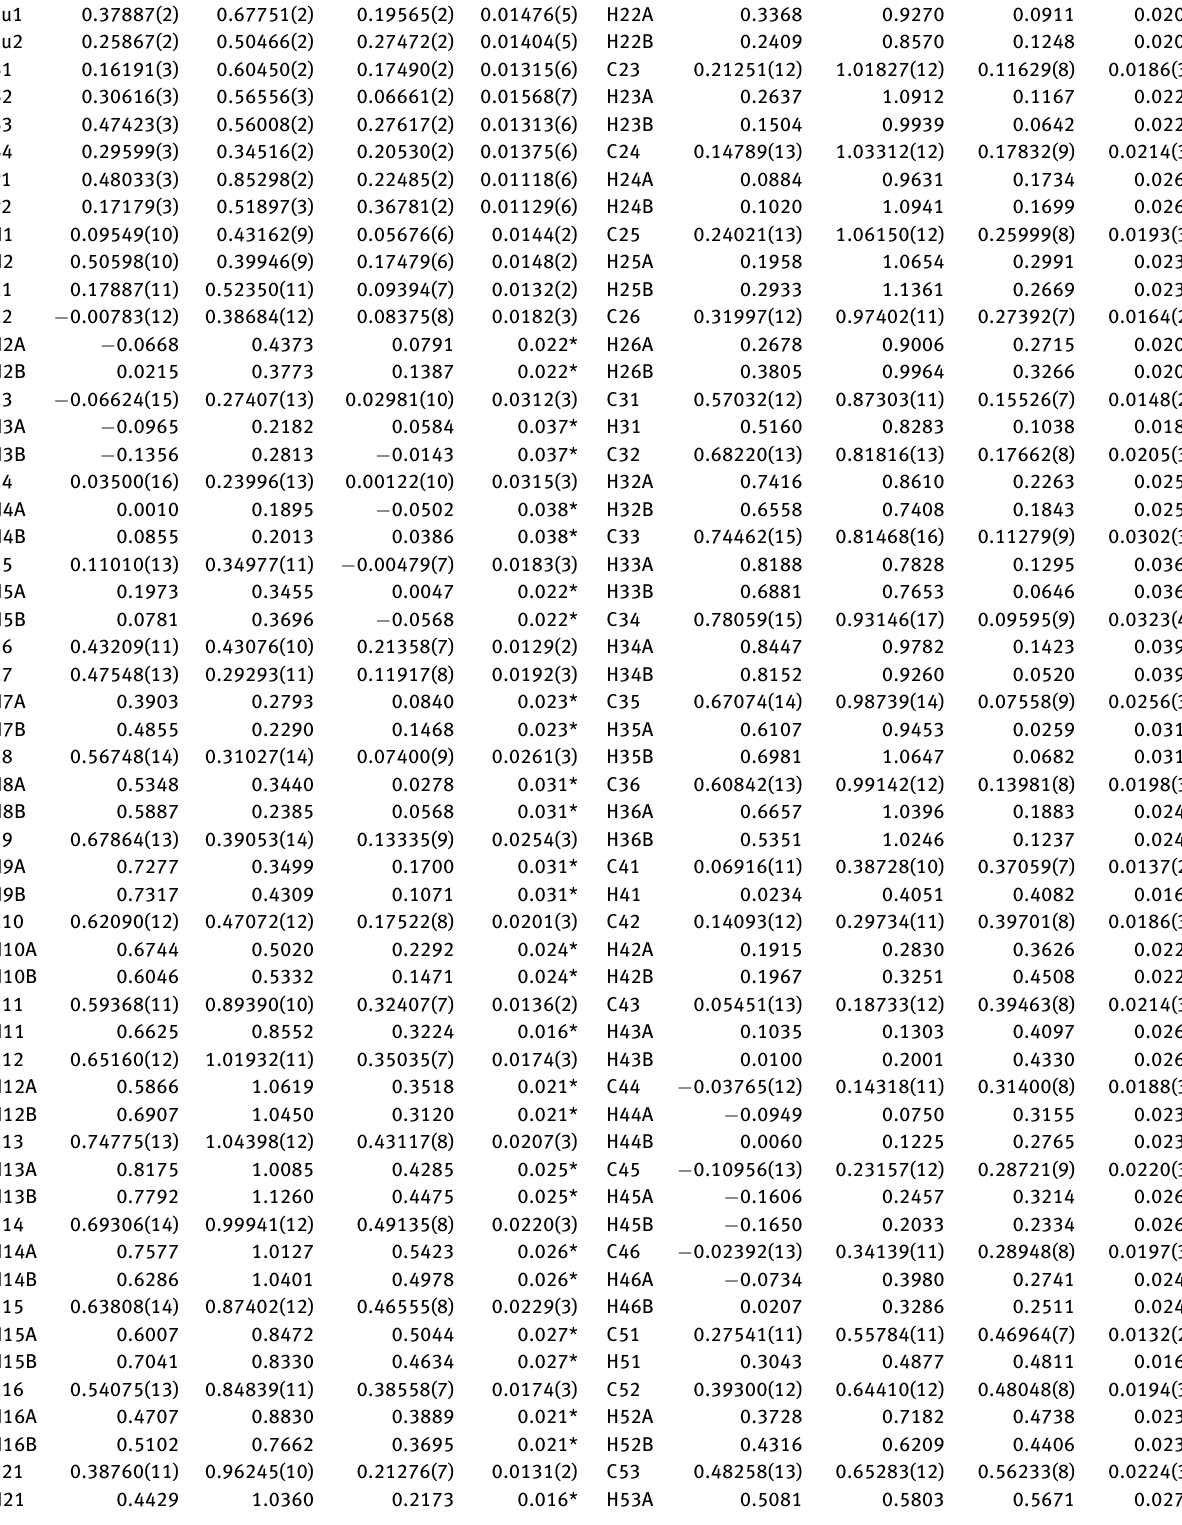
Table 2: Fractional atomic coordinates and isotropic or equivalent isotropic displacement parameters (Å 2